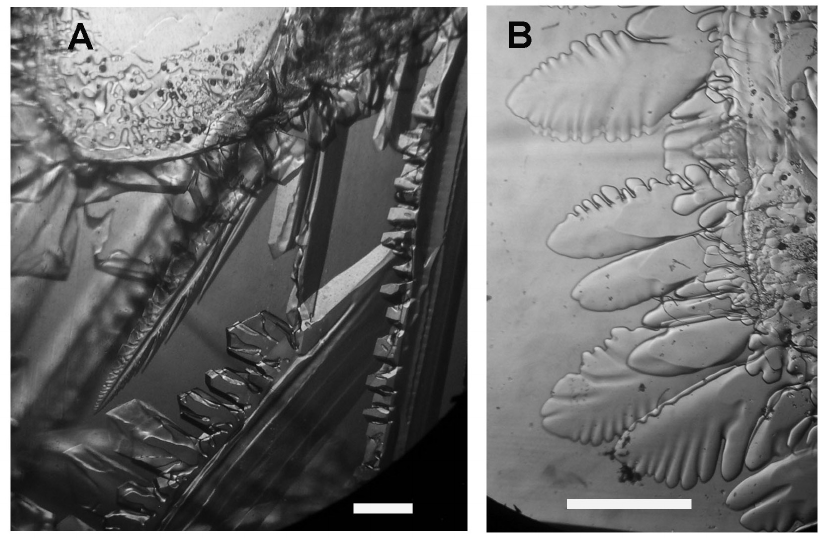
Figure 1. Ice-structuring abilities of grass extracts. ( A ) Leymus mollis rhizome tissue. ( B ) Lawn grass ( Festuca sp.) stem tissue (control). Ice seed crystals were placed in the extracts at slightly below the freezing point. Scale bars, 1 mm.